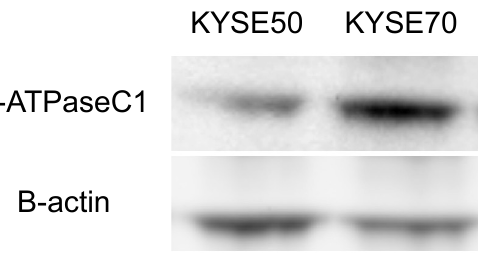
Figure 2. Western blotting to determine for protein expression of V-ATPase in esophageal cancer cell lines .